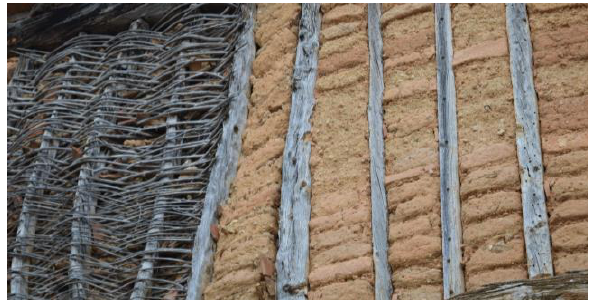
Figure 1. Half-timbered wall with wattle-and-daub (light interwoven fibres) and adobe filling (heavy masonry